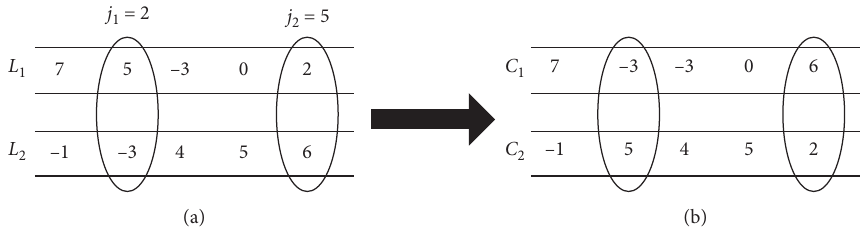
Figure 2: An example of crossover: the 2 nd and the 5 th genes in (L) crossover; (b) after crossover.